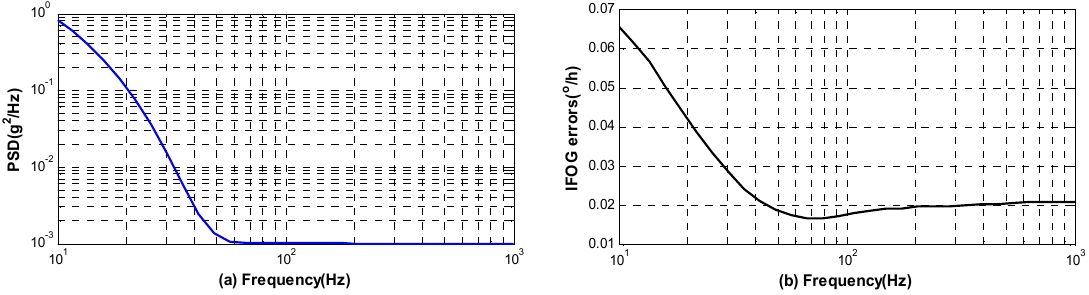
Figure 12. PSD of vibration in F-15B aircraft and the corresponding standard deviation of errors in IFOG ( a ) PSD of vibration; and ( b ) IFOG errors versus PSD.